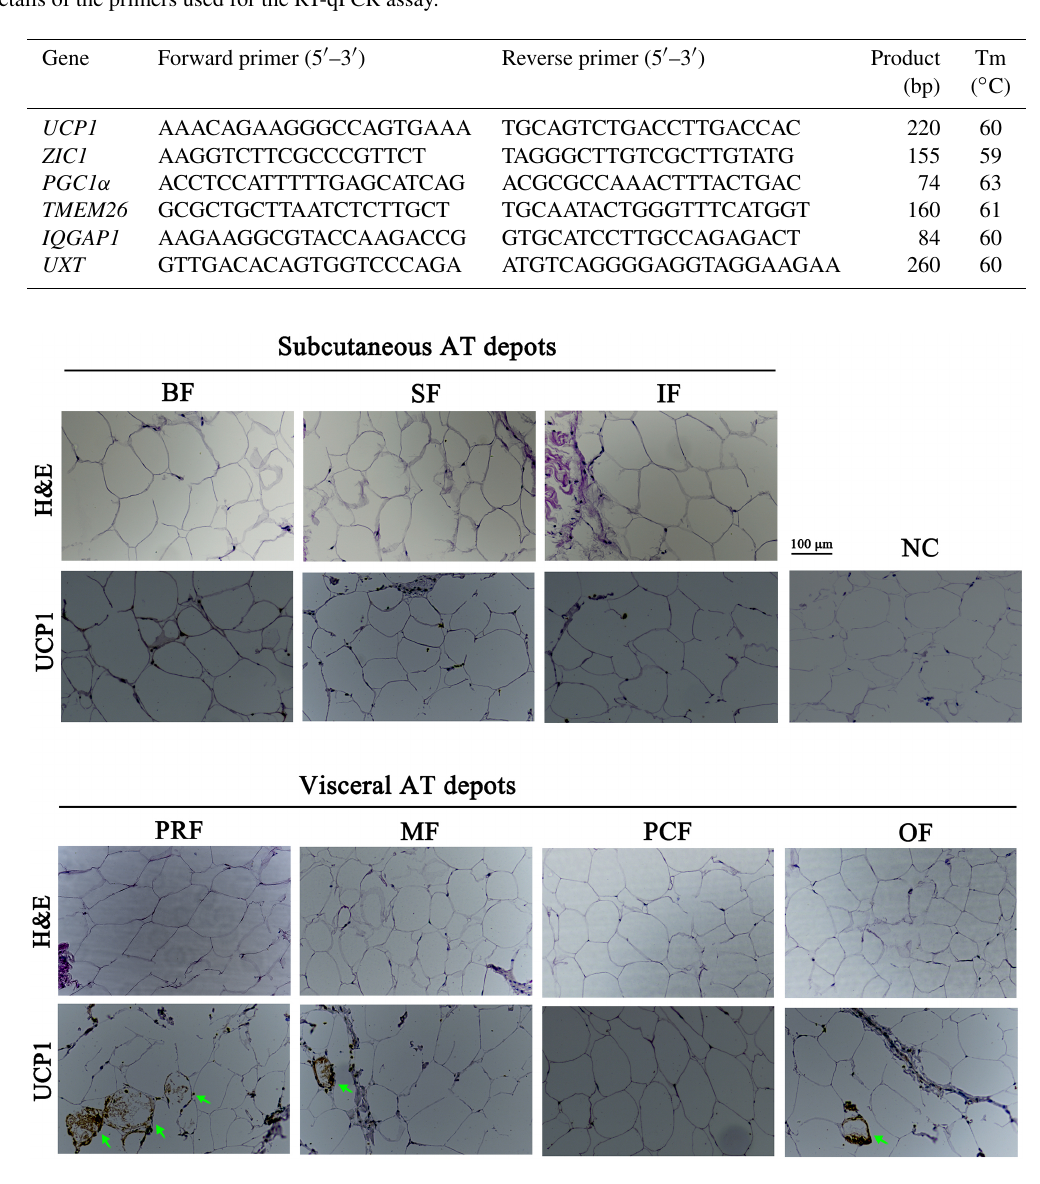
Figure 2. H&E staining and immunolocalization of UCP1 in adipose tissue depots of fattened buffalo. Cellular morphology of the seven adipose tissue depots examined by H&E staining. An immunohistochemistry assay identified UCP1-positive cells (green arrow). NC, negative control. Scale bar,